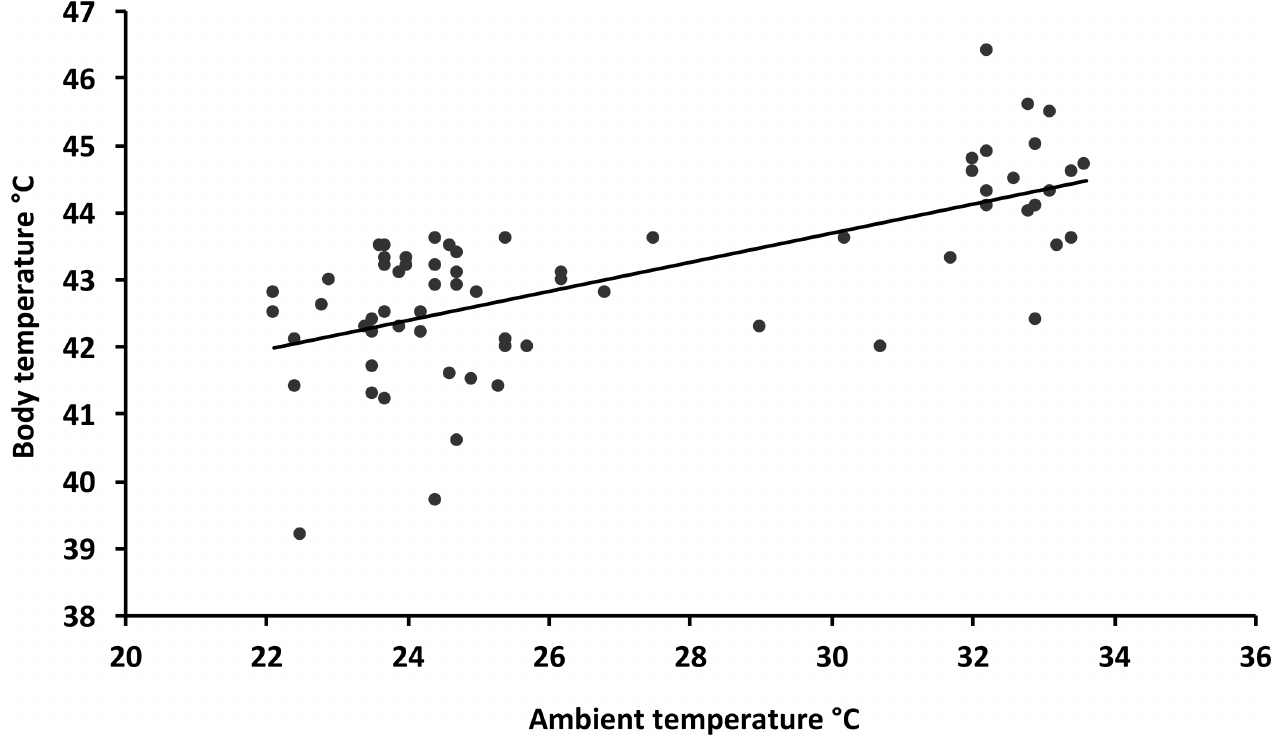
Fig 1. Relationship between ambient temperature in the shade and body temperature. Data from 69 individual birds from 13 different species. Equation of the line: Body temperature = 37.2 + 0.22(ambient temperature); R 2 = 0.45.